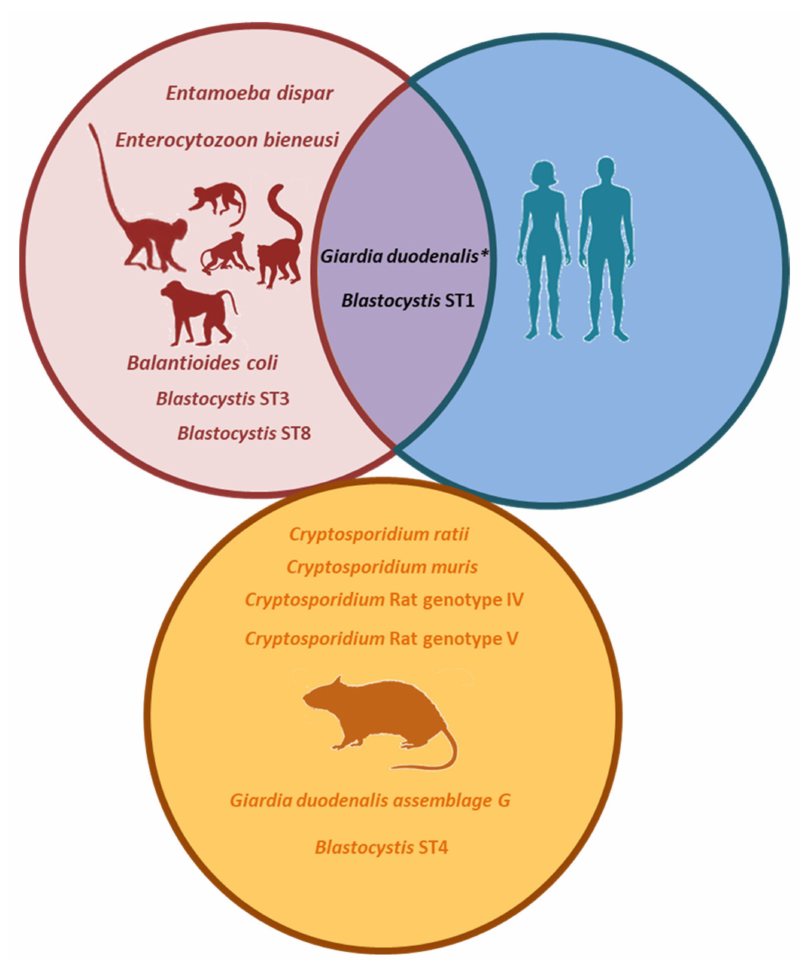
Figure 2. Molecular-based evidence of zoonotic transmission. Enteric protists detected at each species group (non-human primates (NHP), zookeepers and rats) in the C ó rdoba Zoo Conservation Centre (Spain). * Zoonotic Giardia duodenalis assemblage AII was detected in NHP; in addition, two zookeepers were positive for G. duodenalis of unknown assemblage, potentially making the assessment of zoonotic transmission for this protozoan parasite